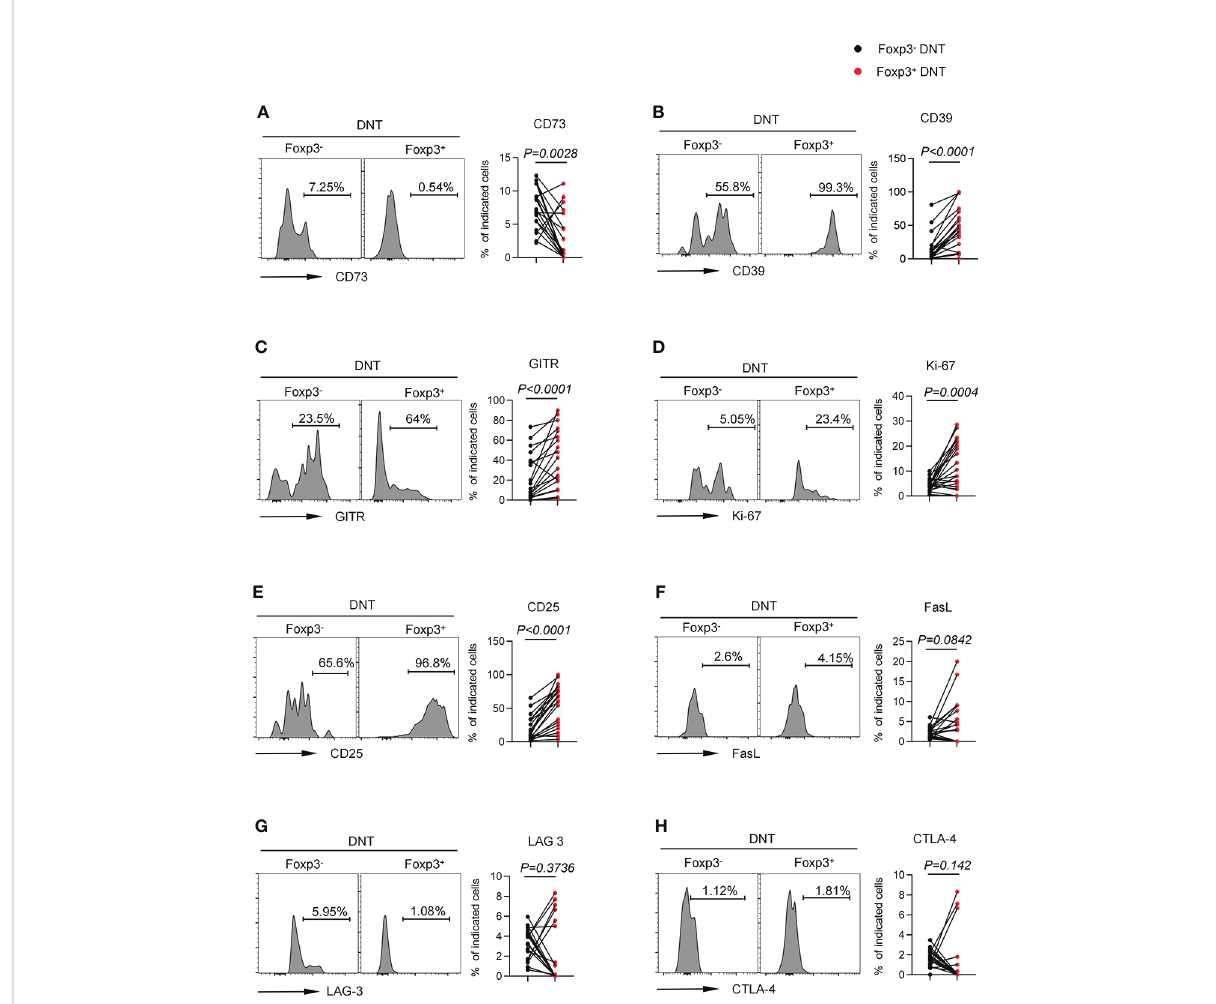
FIGURE 3 Foxp3 + DNT cells showed a unique phenotypic characteristic compared with their circulating Foxp3 - counterpart in TNs. Flow cytometry analysis of expression of CD73 (A) , CD39 (B) , GITR (C) , Ki-67 (D) , CD25 (E) , FasL (F) , LAG-3 (G) and CTLA-4 (H) on Foxp3 - vs . Foxp3 + DNT cells from TNs with baseline CD4 + T cell count ≤ 200 cells/µl. Representative histograms (left) and plots (right) displayed the expression of the above markers on Foxp3 - vs . Foxp3 + DNT cells. P values were obtained by Wilcoxon matched-pairs signed rank